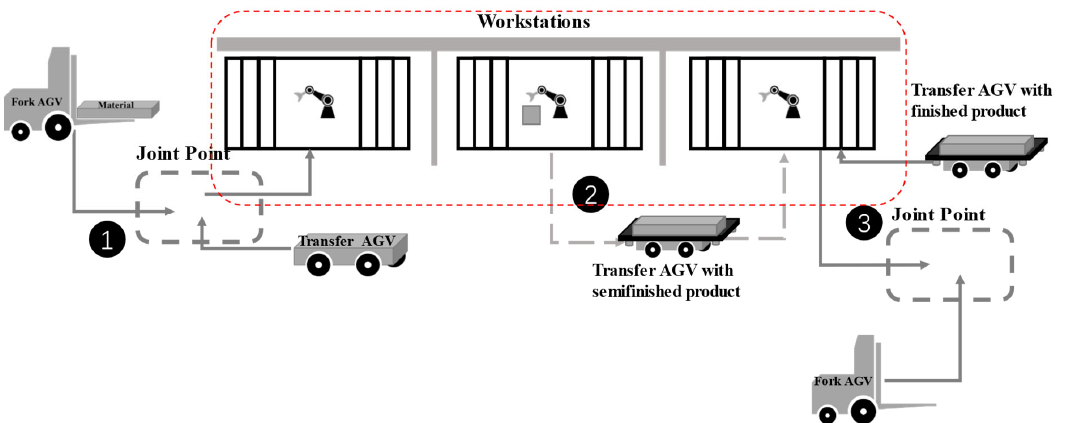
Fig. 1. Transportation of a complete process in the manufacturing system